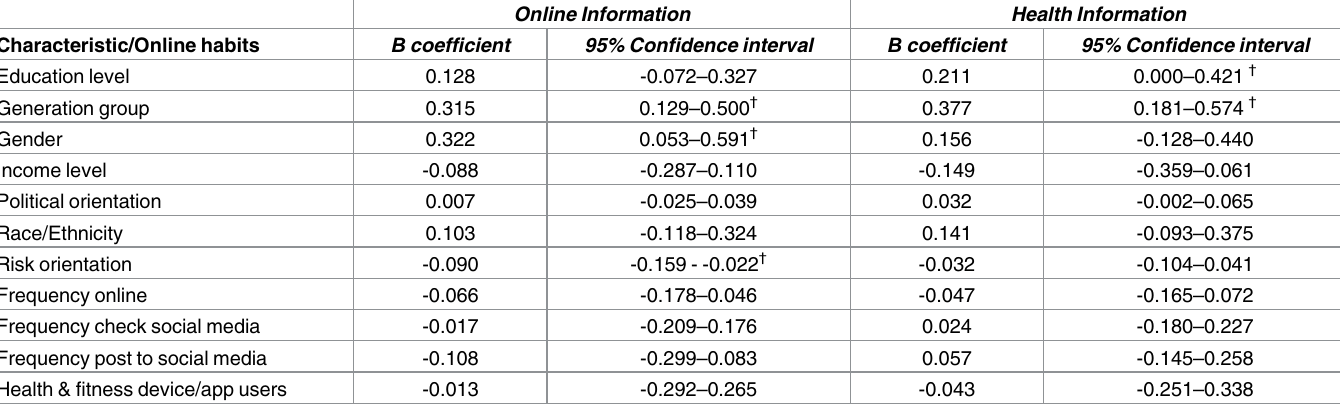
Table 3. Predictors of level of concern about security of online and health information * .